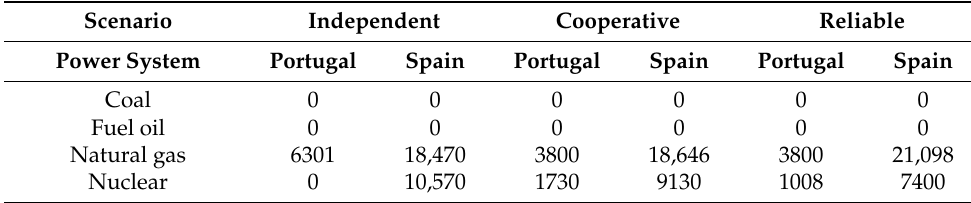
Table 9. Optimal thermal capacity (MW) in 2018.